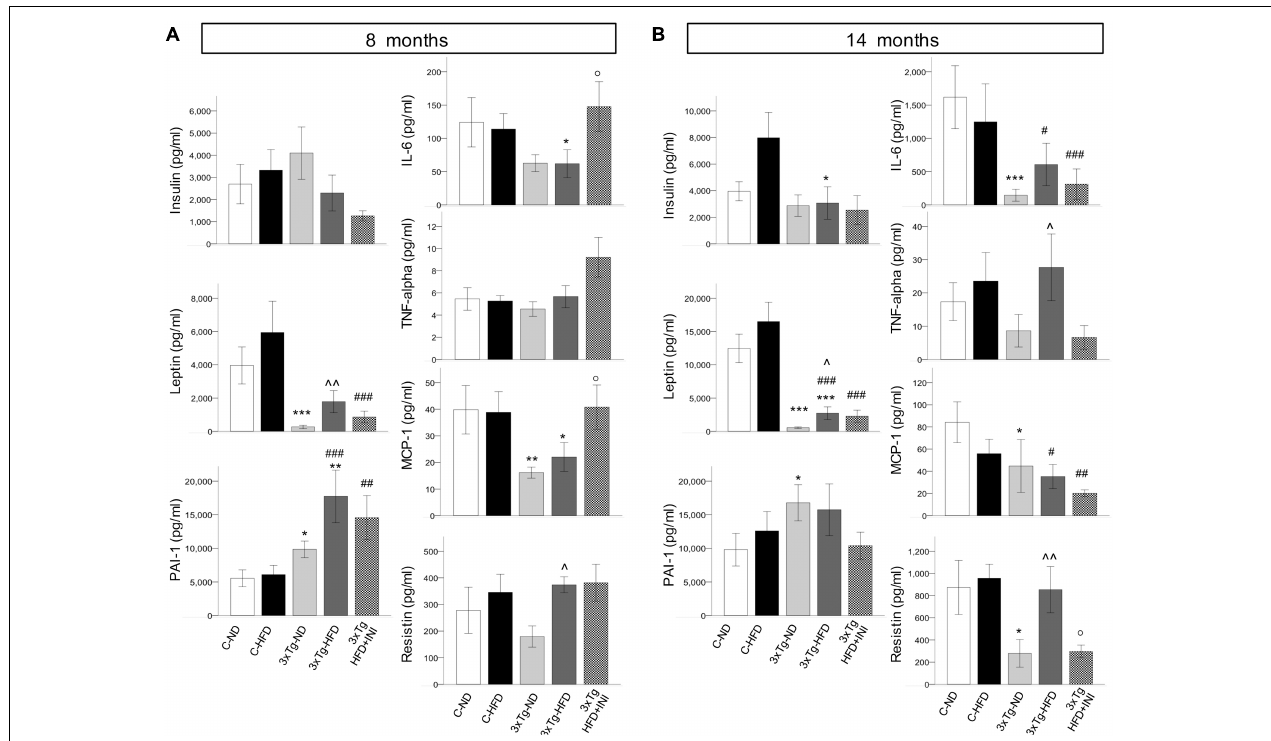
FIGURE 4 | Plasma levels of cytokines and adipokines measured in each study group at final time-points of 8 (A) and 14 months of age (B) . Data are presented as mean ± SEM (non-normally distributed data were normalized with logarithmic transformation, and parametric tests were used). Sample sizes are given in Table 1 . ∗ p < 0.05 or less ( ∗∗ , ∗∗∗ ) ND-ND and HFD-HFD (between strains), ∧ p < 0.05 or less ( ∧∧ ) HFD vs. ND (within-strain), # p < 0.05 or less ( ## , ### ) vs. ND control group (reference group), ◦ p < 0.05 for treated 3 × Tg-HFD + INI vs. untreated 3 × Tg-HFD.